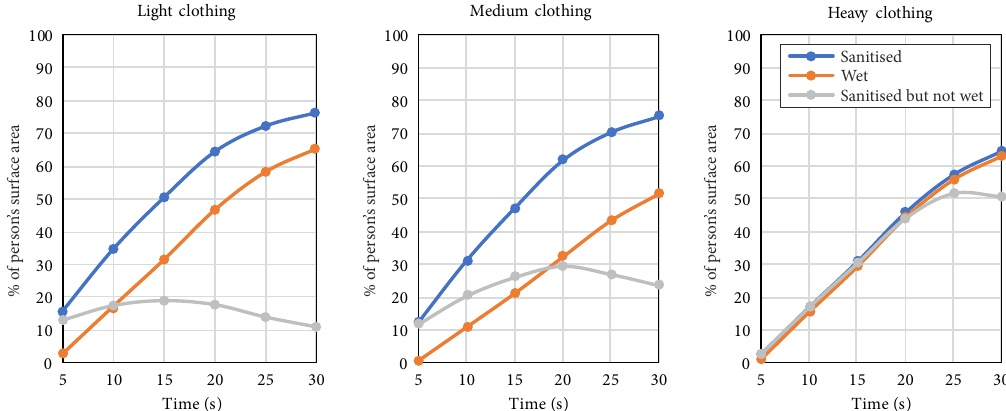
Figure 11. Performance of optimised chamber for different